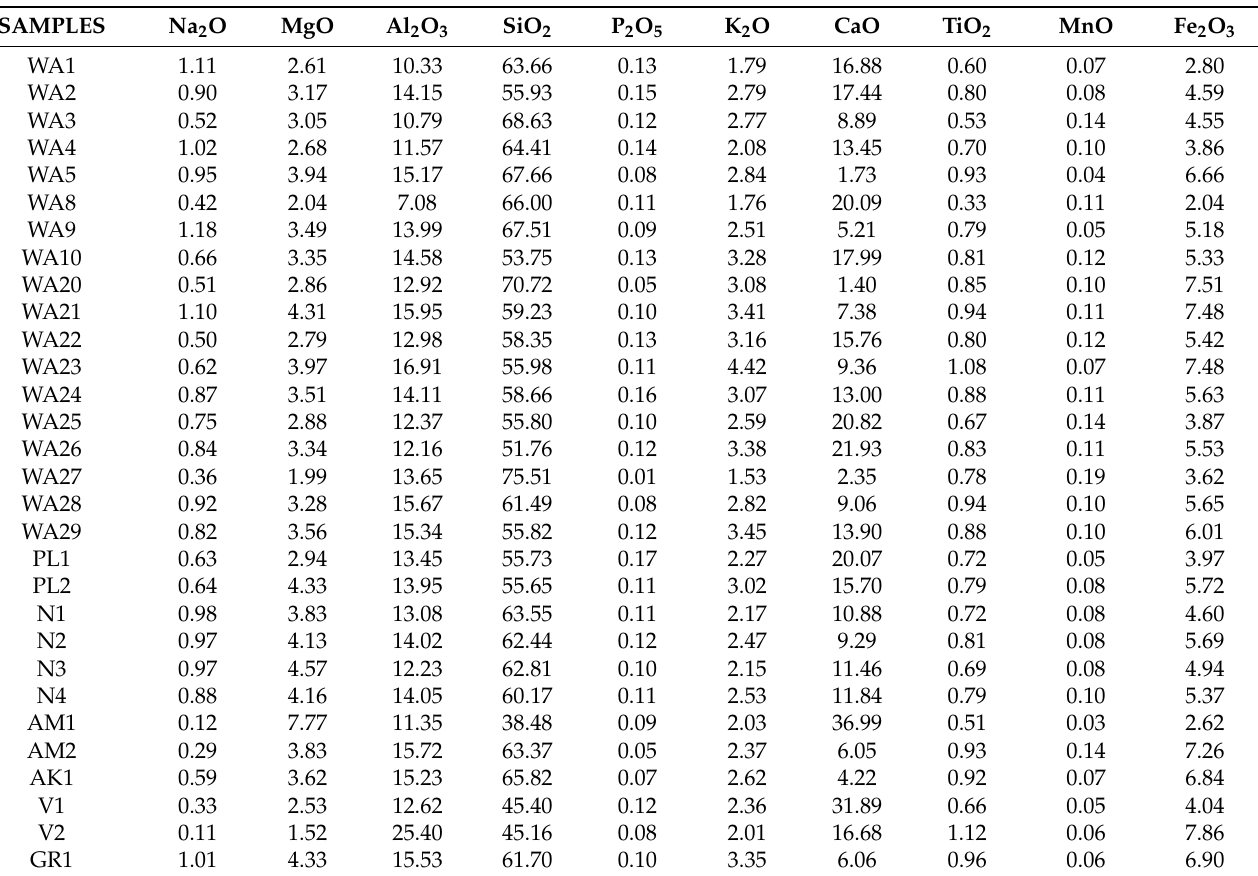
Figure 8. Plots of the elemental ratios ( a ) Th/Sc-La/Sc; ( b ) Th/Cr-La/Cr; ( c ) La/Sc-La/Cr; and ( d ) Th/Cr-La/Sc. The data of EA, X, and C are published elsewhere [12].